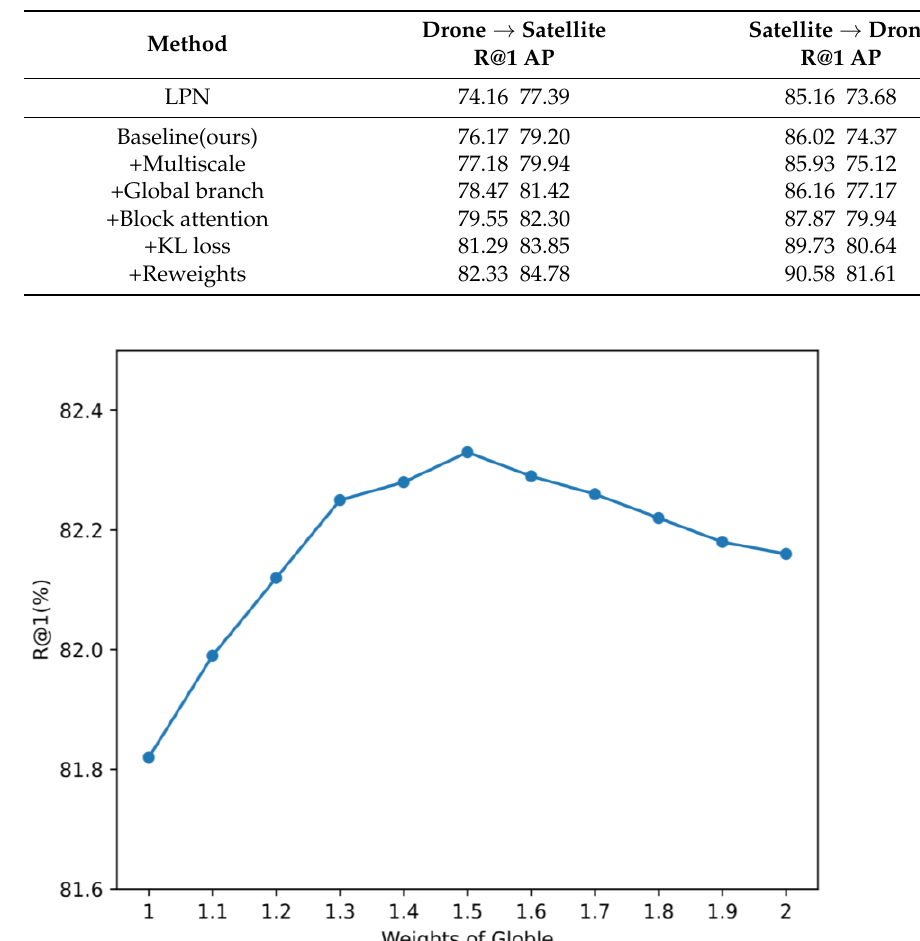
Figure 6. Effect of global branch weights.